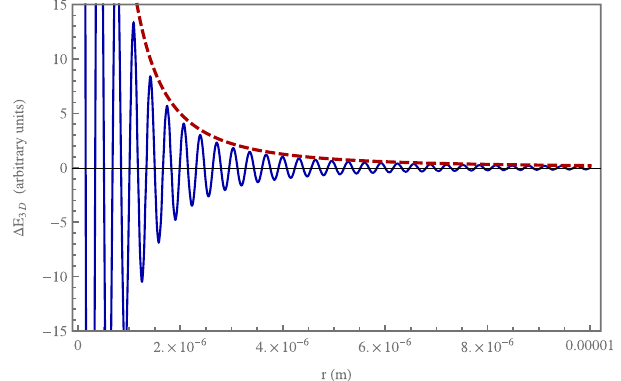
Figure 2. Plot of the resonance interaction energy Δ E 3 D in arbitrary units for distances of the atoms between 10 − 7 m and 10 − 5 m obtained by a numerical integration using the exact dispersion relation of the photonic crystal (blue continuous curve). The atomic dipoles are assumed equal and oriented perpendicularly to the atomic distance. Parameters are such that n = 3, a = 2 · 10 − 8 m, ω a = 2.65 · 10 15 s − 1 , and thus k 0 = 1.96 · 10 7 m − 1 . The red dashed line represents the function r − 2 . The figure clearly shows the asymptotic power-law decay as r − 2 , in agreement with the analytical results obtained using our approximate dispersion relation in the first Brillouin zone of the photonic